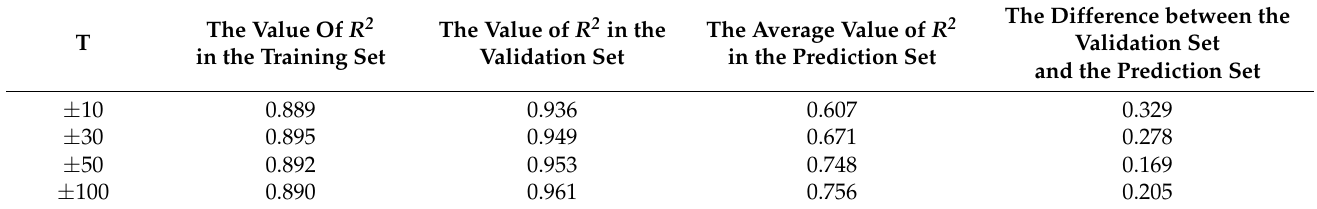
Table 2. The duration of seismic activities (T) impact on the precursor anomaly